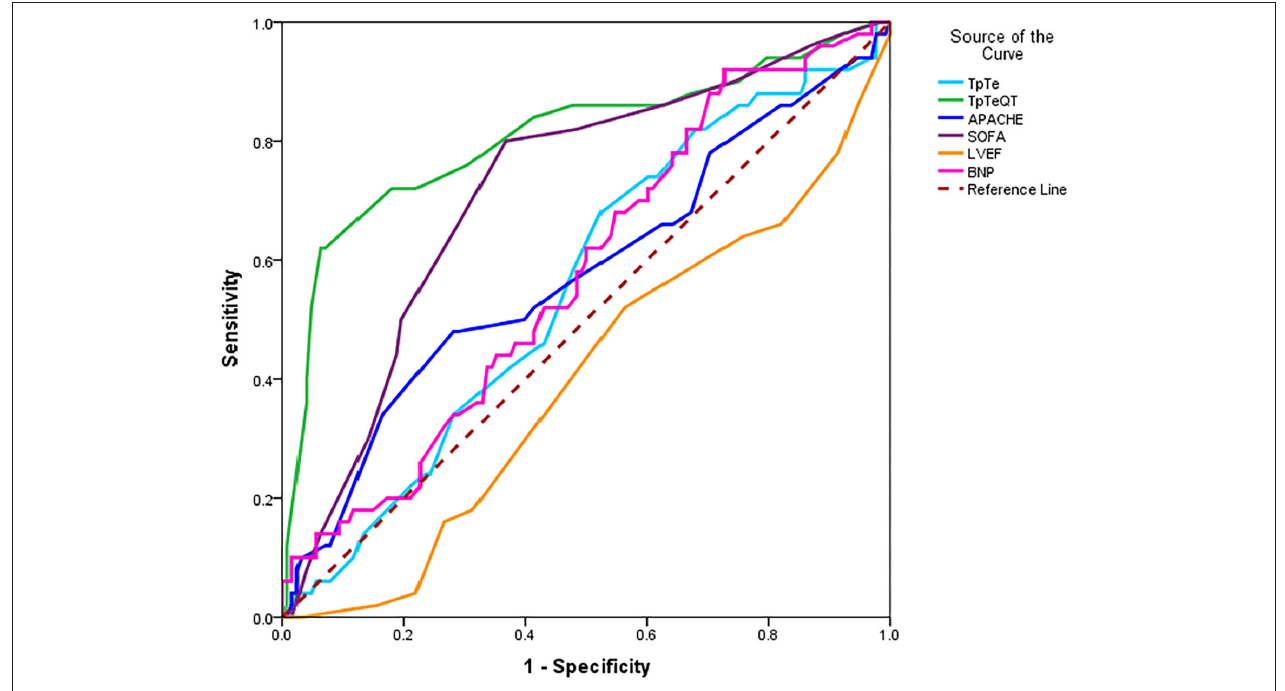
FIGURE 2 | ROC curves of different indicators in sepsis patients.